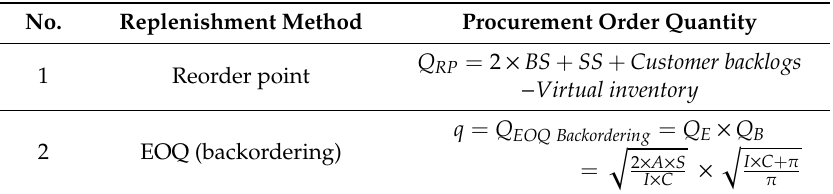
Table 6. Procurement order quantity (own elaboration).